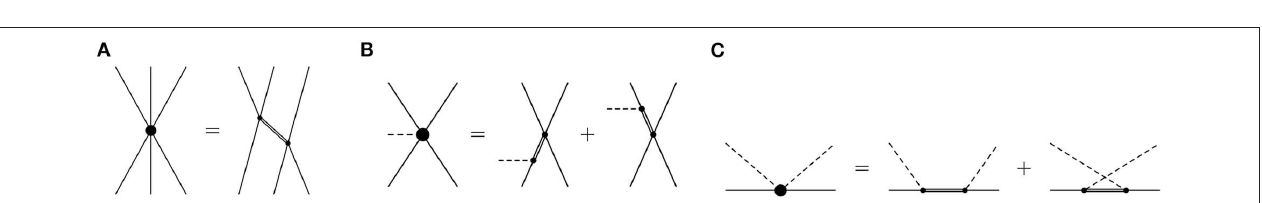
FIGURE 11 | Saturation via decuplet resonances. (A) Saturation of the six-baryon contact interaction. (B) Saturation of the BB NLO baryon-meson vertex.